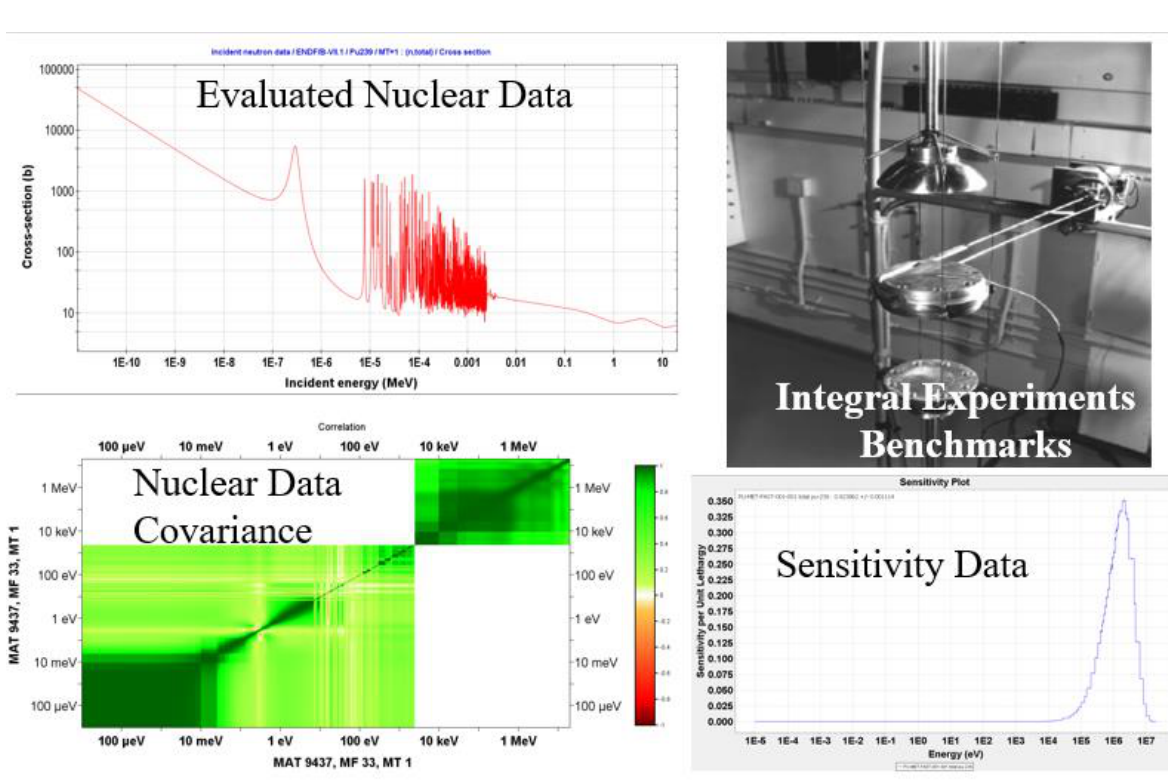
Figure 1. Key components of nuclear data testing and